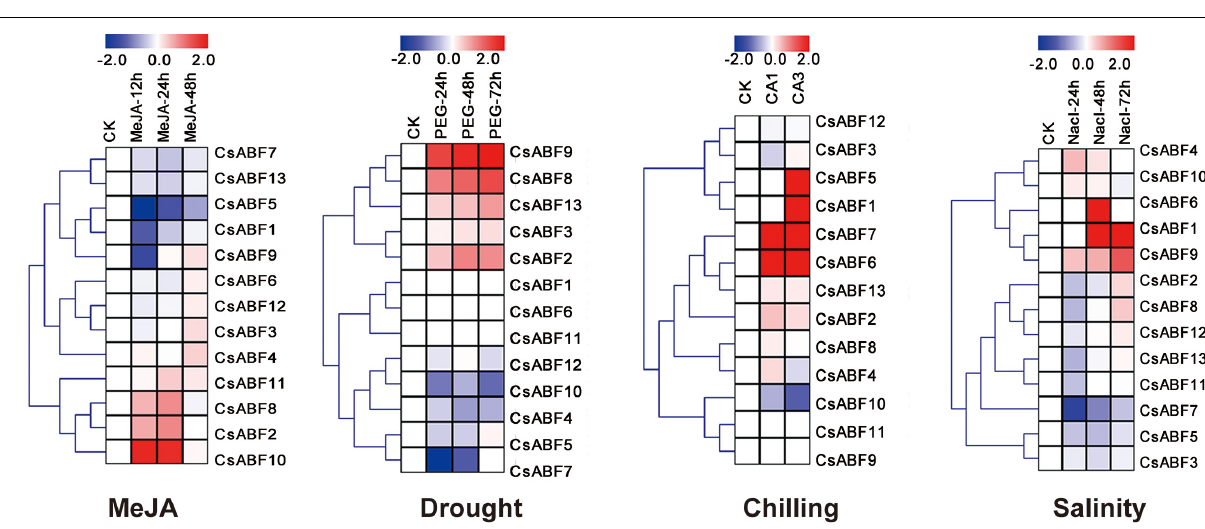
FIGURE 3 | Heatmap of CsABF gene expression under different abiotic stress treatments. Stress treatments include methyl jasmonate (MeJA), drought (PEG), chilling and salinity stress. The FPKM values of the Illumina RNA-seq data were reanalyzed and log2 transformed. The color scale represents the gene expression level; blue represents down-regulation, and red represents